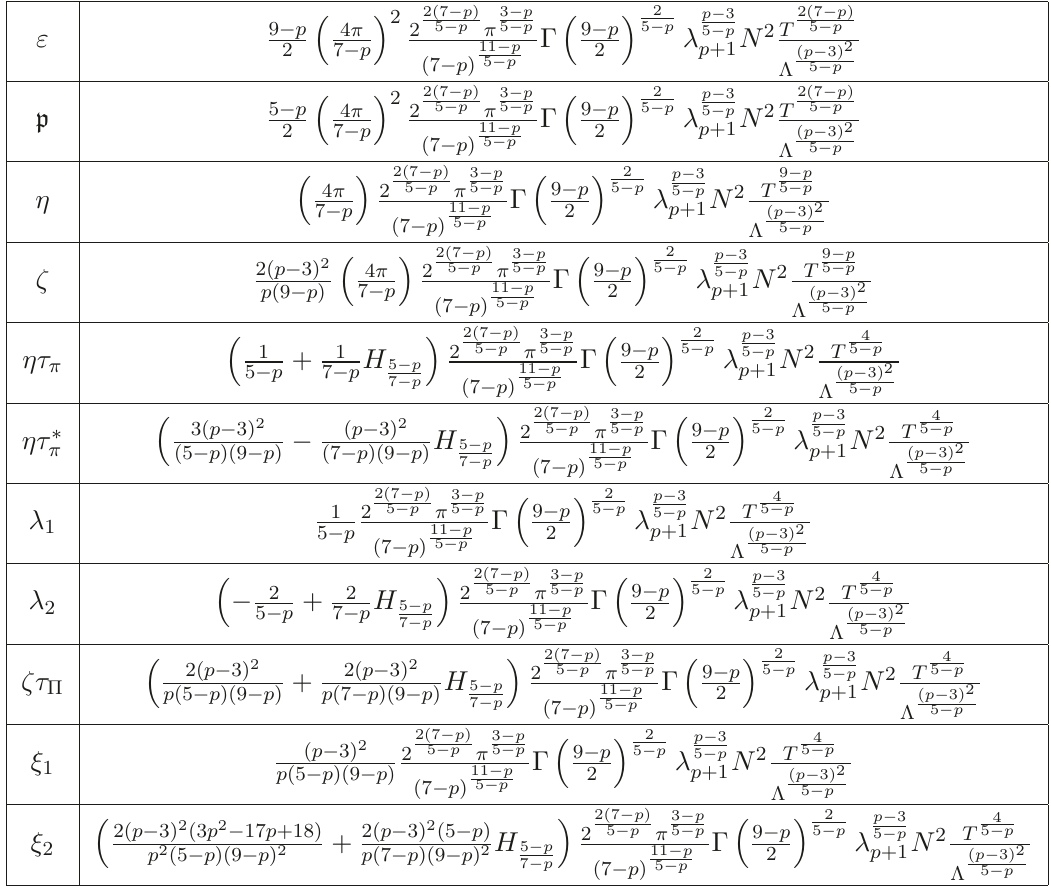
Table 3 . Reformulation of the results in field theory language. Remember that λ 3 and ξ 3 are both